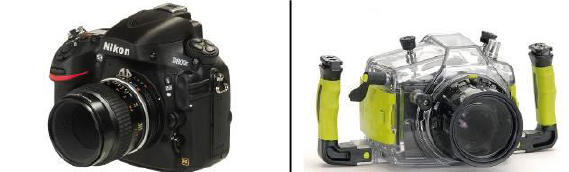
Figure 1. Cameras employed: on the left NikonD800E, on the right Nikon D7100 housed